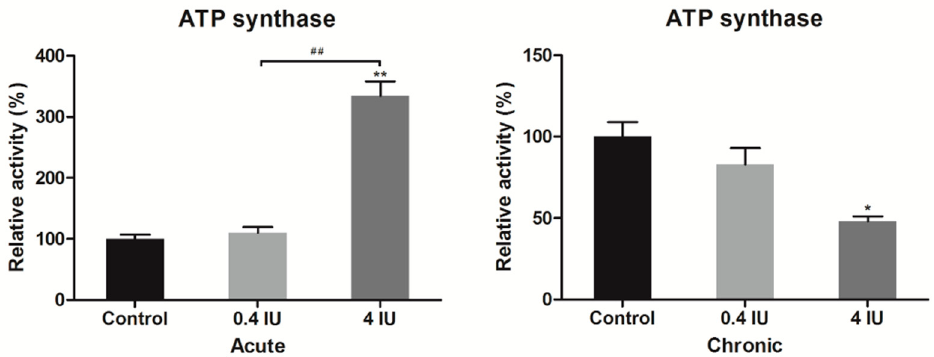
Figure 8. Relative ATP synthase activity following acute and chronic insulin treatment. Data showing ATP synthase activity, expressed relative to a control (taken as 100%), represent the means ± SEM values of three independent experiments. * compared to control: * p ≤ 0.05, ** p ≤ 0.01; # 0.4 IU vs. 4 IU: ## p ≤ 0.01.